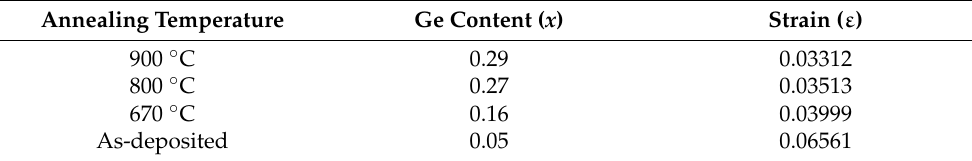
Table 2. Germanium content and strain in as-deposited and annealed SiGe thin films.